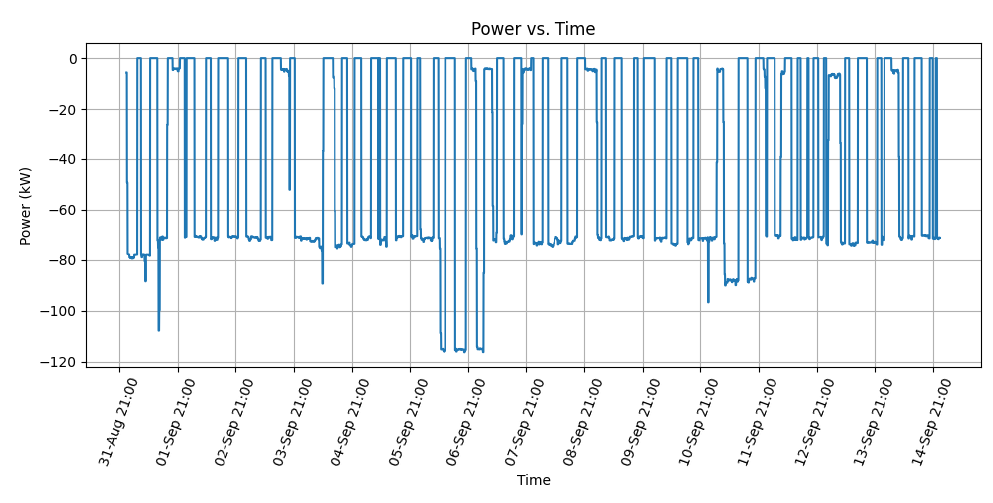
Figure 3. Power load profile over two-week time horizon.